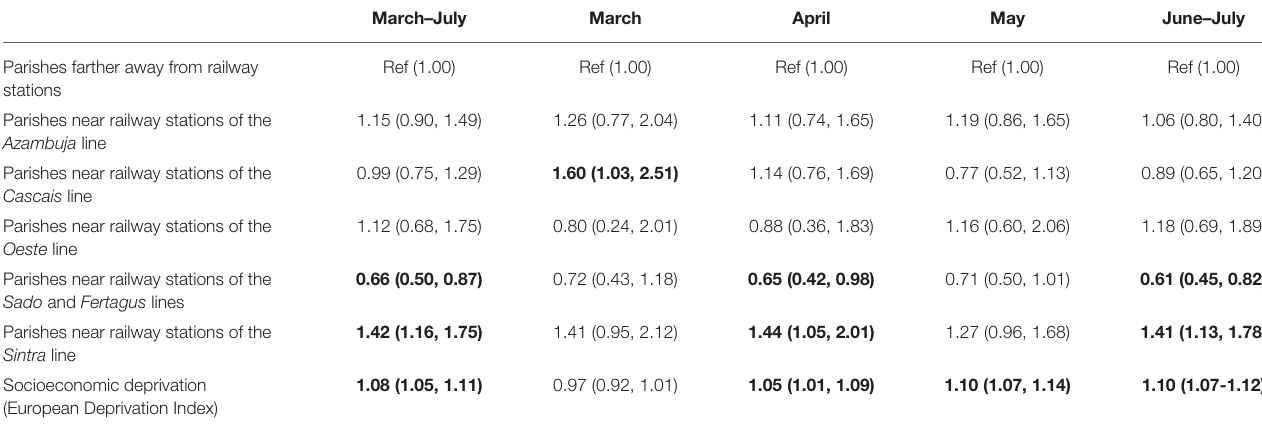
TABLE 1 | Associations (Relative Risk, RR, and 95% Confidence Intervals, 95%CI) between proximity to railway stations and SARS-CoV-2 infection